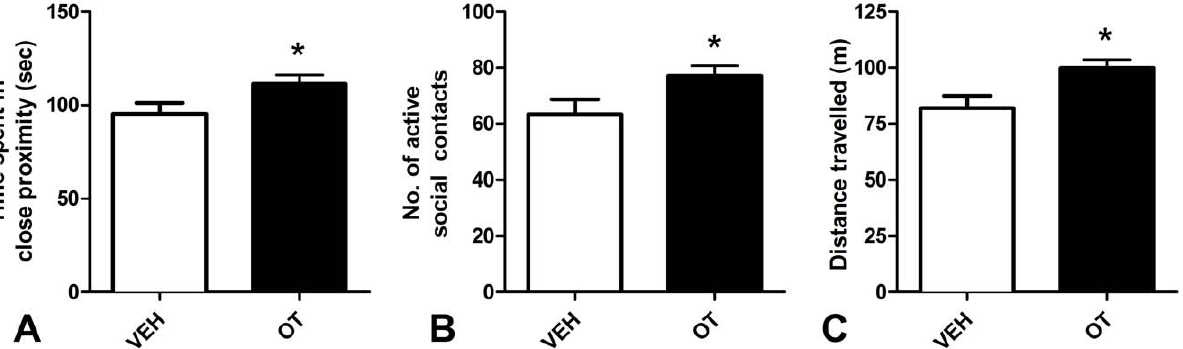
Figure 3. Social interaction test. Results from a 5 min social interaction test conducted 13 days after the cessation of 10 consecutive days of once per day treatments with either 1 mg/kg OT or VEH. A. Mean ( + SEM) seconds the two subjects spent in close proximity (within one body length). B. Mean ( + SEM) number of active social contacts between the subjects. C. Mean ( + SEM) meters travelled by each pair of subjects (on average) during the social interaction test. N=24 per condition. * Significantly different to VEH, p ,